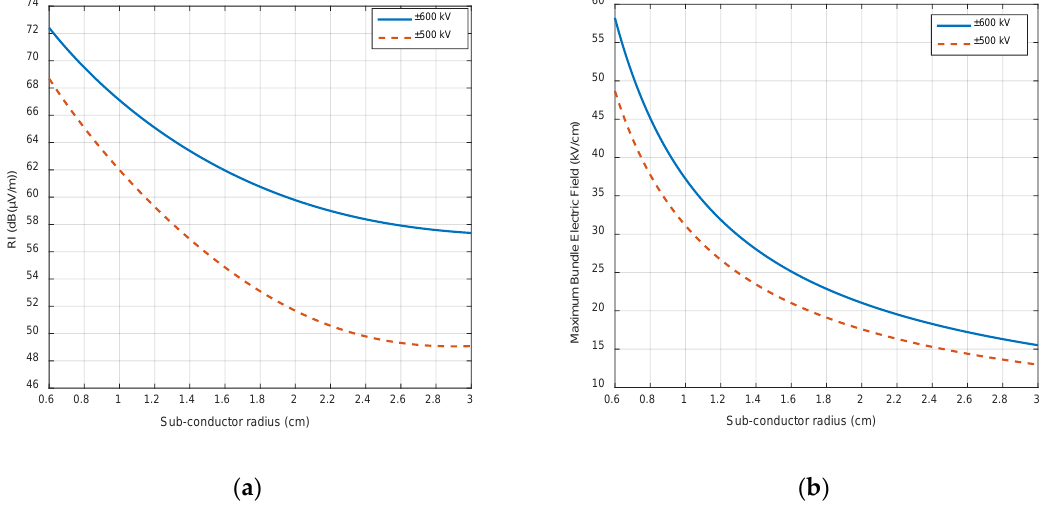
Figure 5. Parametric sweeps: ( a ) RI as a function of sub-conductor radius; ( b ) Maximum bundle electric field ( g max ) as a function of sub-conductor radius.